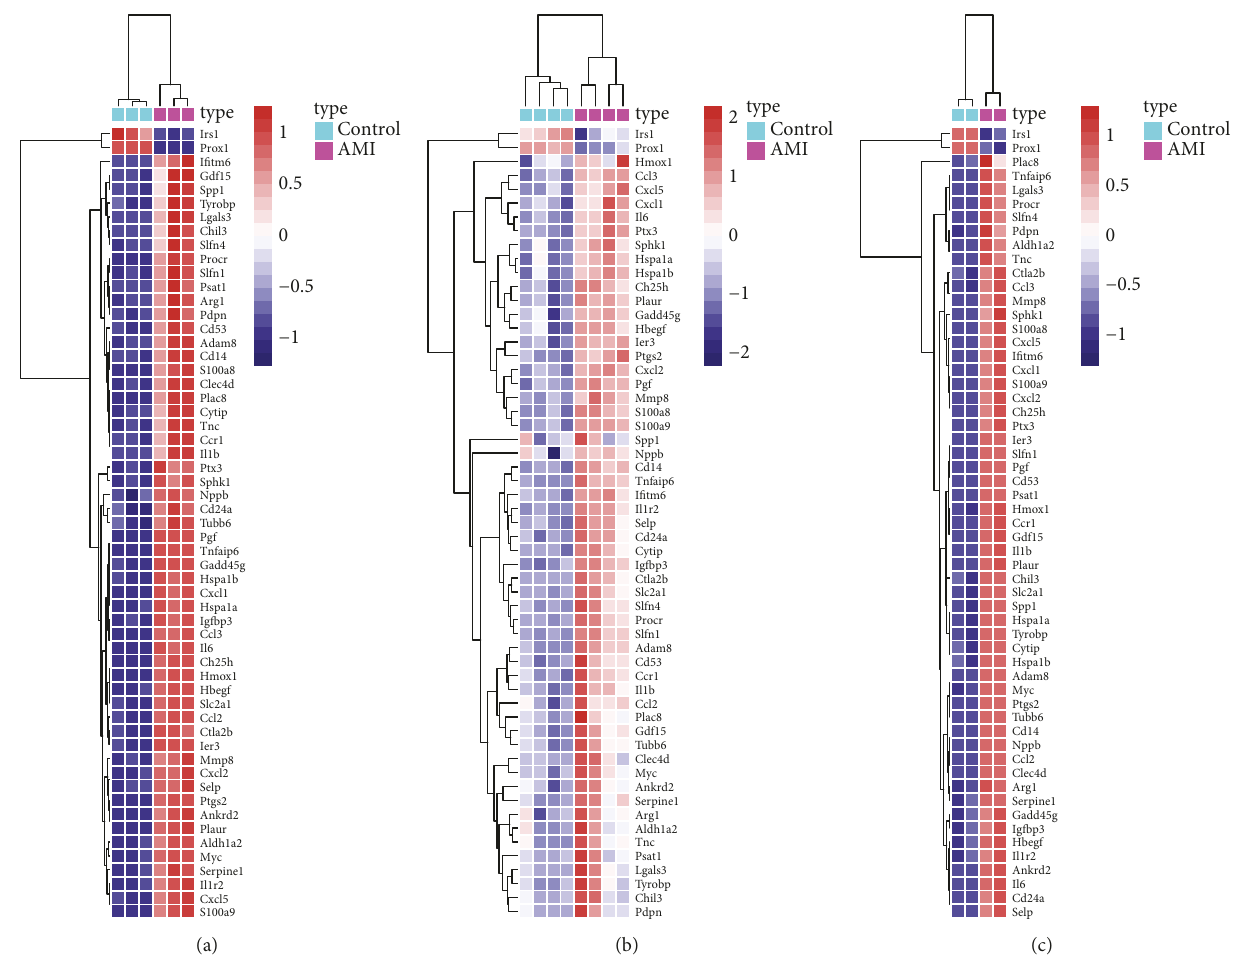
Figure 2: Hierarchical clustering heatmap of DEGs, which was screened on the basis of log2FC > 1.0 and a corrected p < 0.05. Notes: (a) GSE775 data, (b) GSE19322 data, and (c) GSE97494 data. Red represents that the expression of genes is relatively upregulated. Blue represents that the expression of genes is relatively downregulated. Gray represents the expression of genes without significant changes. Abbreviation: DEGs, differentially expressed genes; FC, fold change.